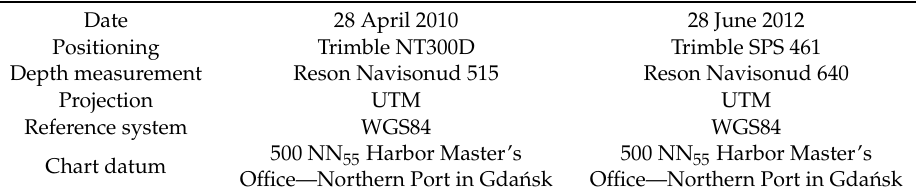
Table 2. Major measurement parameters around the pier in Sopot in 2010 and 2012 campaigns.